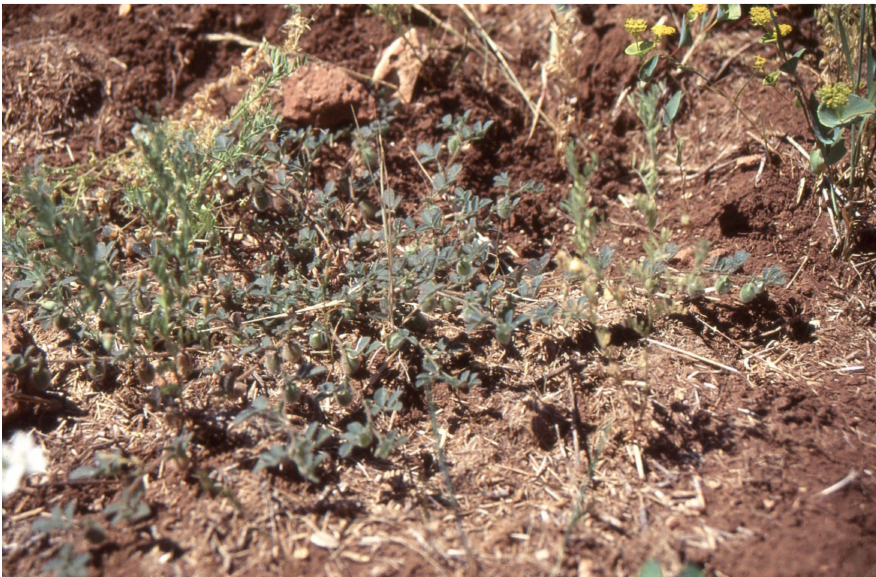
Figure 7. A wild C. bijugum plant (center) after hand harvest of a lentil field near Midyat, southeast Turkey, June 2002. Note the two (pale green) lentil plants that were left by the harvesters (probably due to their close proximity to the wild chickpea plant). Note the intact morphology of the wild chickpea; in sharp contrast to the (damaged) plants depicted in Figures 2 and 3 (photo by S